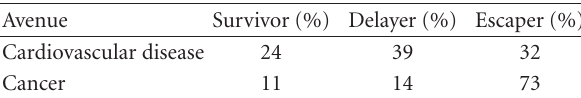
Outcomes (columns) are significantly di ff erent ( P < . 0001) between disease categories by an exact test